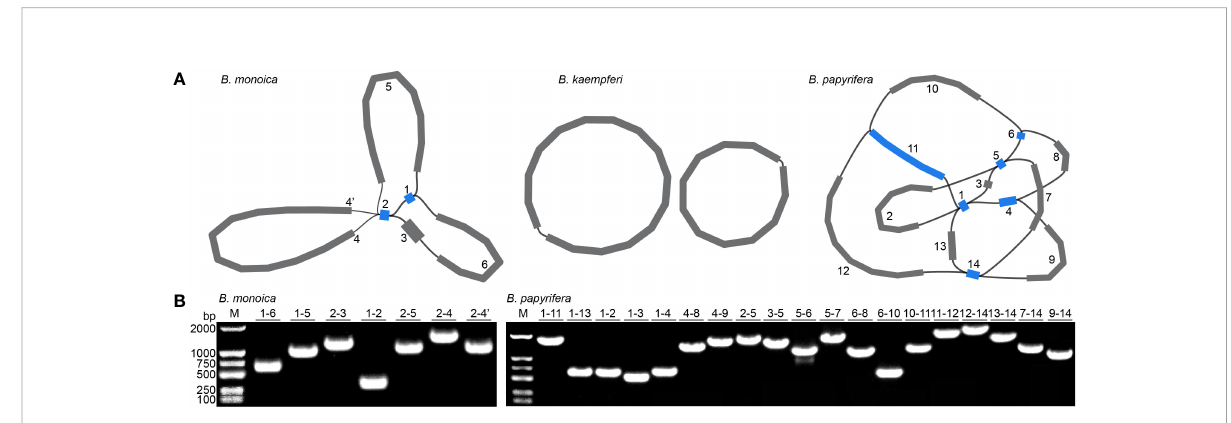
FIGURE 1 Mitogenome assembly graph and possible connections (black lines) mediated by repeats. (A) Mitogenome assembly graph of B monoica , B kaempferi , and B papyrifera . Unique and repeated contigs are colored in grey and blue, respectively. (B) PCR veri fi cation of possible